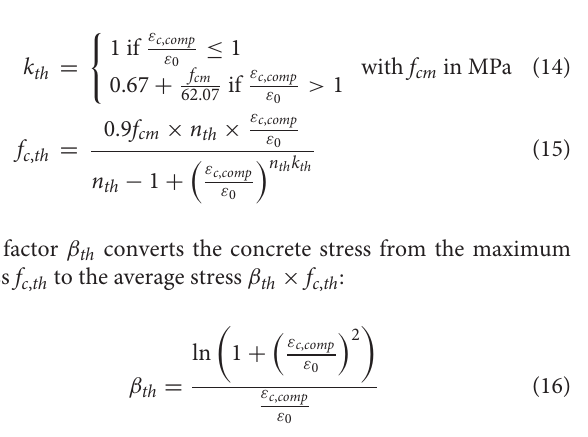
FIGURE 2 | Singly reinforced rectangular concrete beam at moment of achieving stop criterion for concrete strain based on flexural theory: (A) cross-section of beam; (B) strains; (C) stresses; (D) resultant forces. Modified from (Lantsoght et al., 2018).